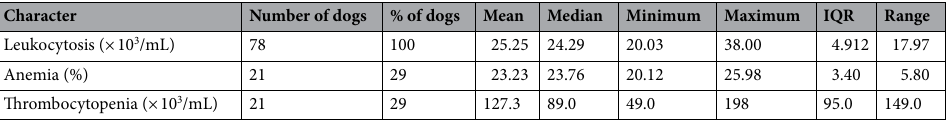
Table 5. Abnormalities observed in full blood count in hump-nosed pit viper envenomed dogs. IQR Interquartile